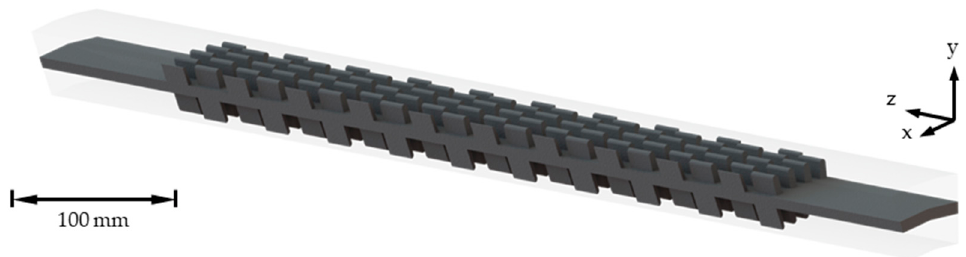
Figure 5. Geometry used for the detailed simulations of the recuperator from a Rekumat ® M250